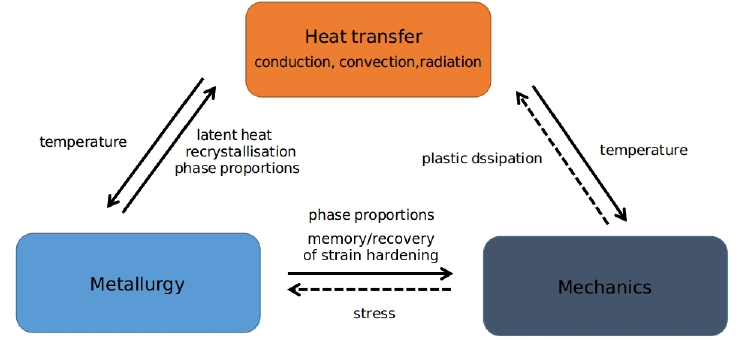
Figure 1. Multiphysics couplings during welding processes. Dotted arrows denote effects disregarded most of the